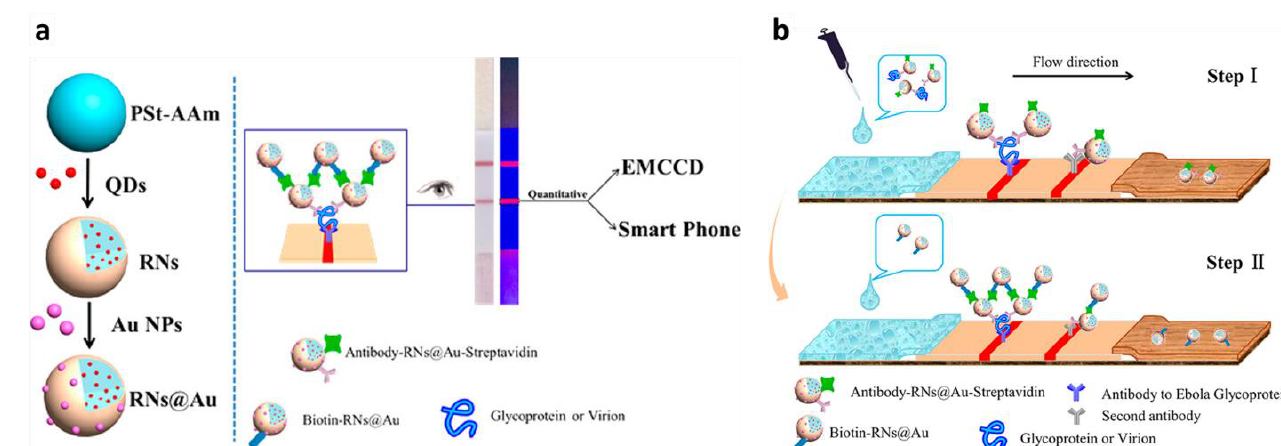
Figure 4. Schemes follow the same formatting. Schematic diagram of polymeric nanosphere from poly(styrene/acrylamide) for LFA − signal amplification. ( a ) Illustration of QD and AuNP function- alization on the polymeric nanosphere. ( b ) Two − step detection of Ebola virus with functionalized nanosphere in LFA. Adapted with permission from [39] . Copyright 2017, American Chemical Soci- ety.